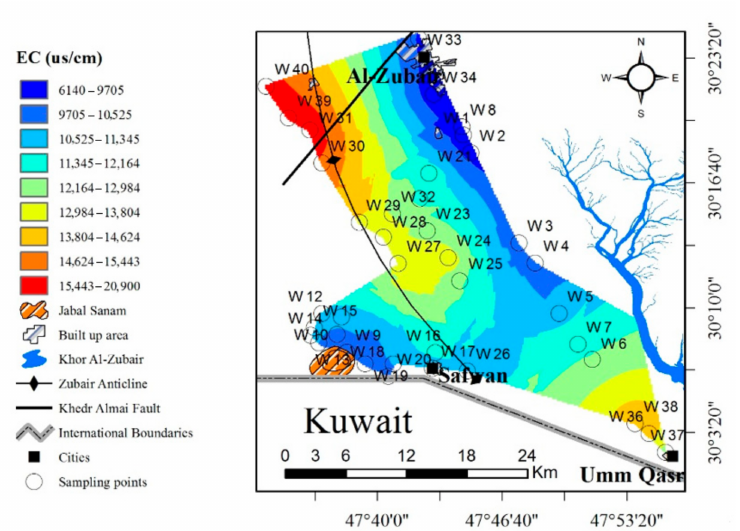
Figure 3. Spatial distribution of groundwater EC in the upper Dibdibba unconfined